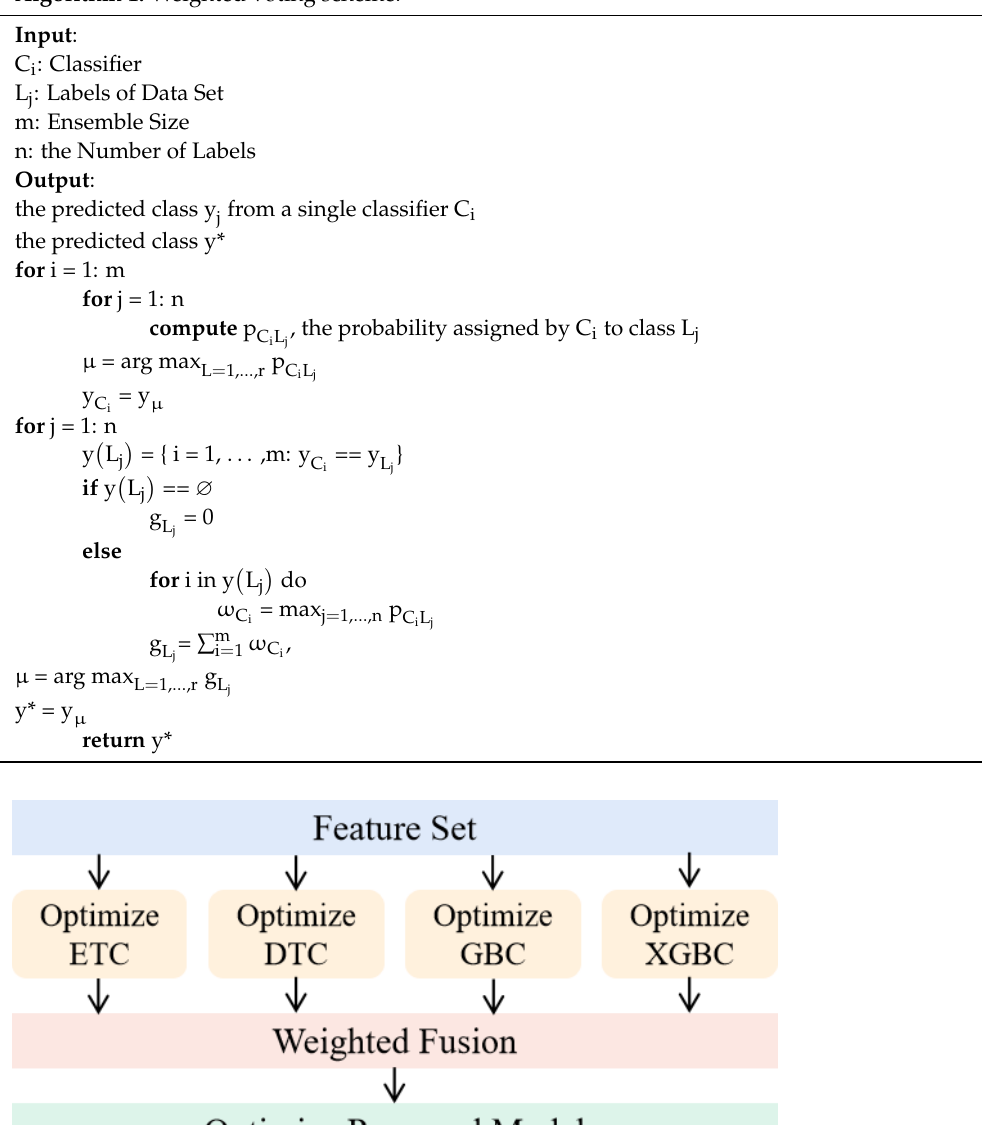
Algorithm 1. Weighted voting scheme.